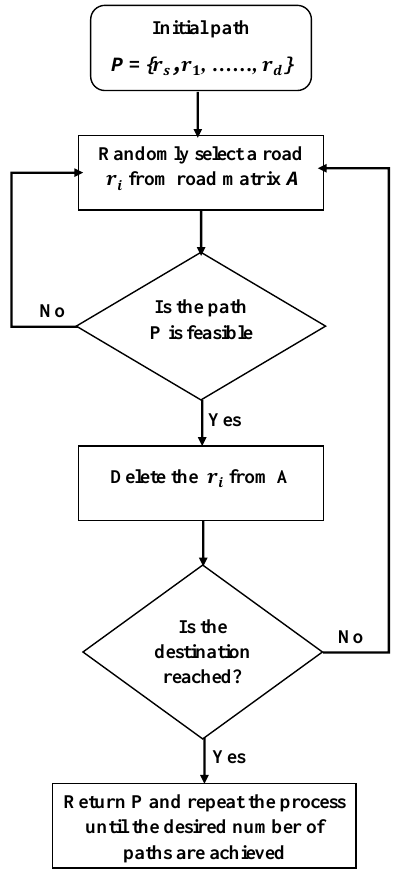
Figure 2. The procedure of generating a random